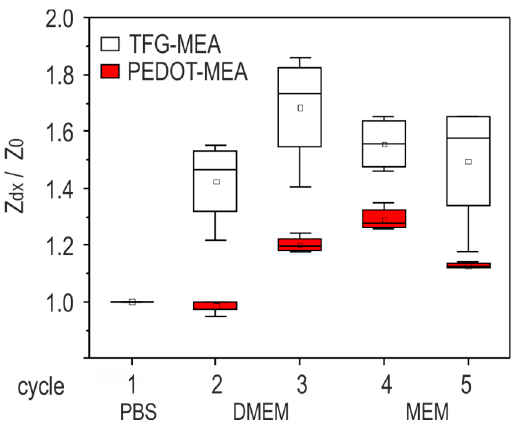
Figure 5. Box plot of impedance magnitude (1 kHz) after cleaning and conditioning steps.